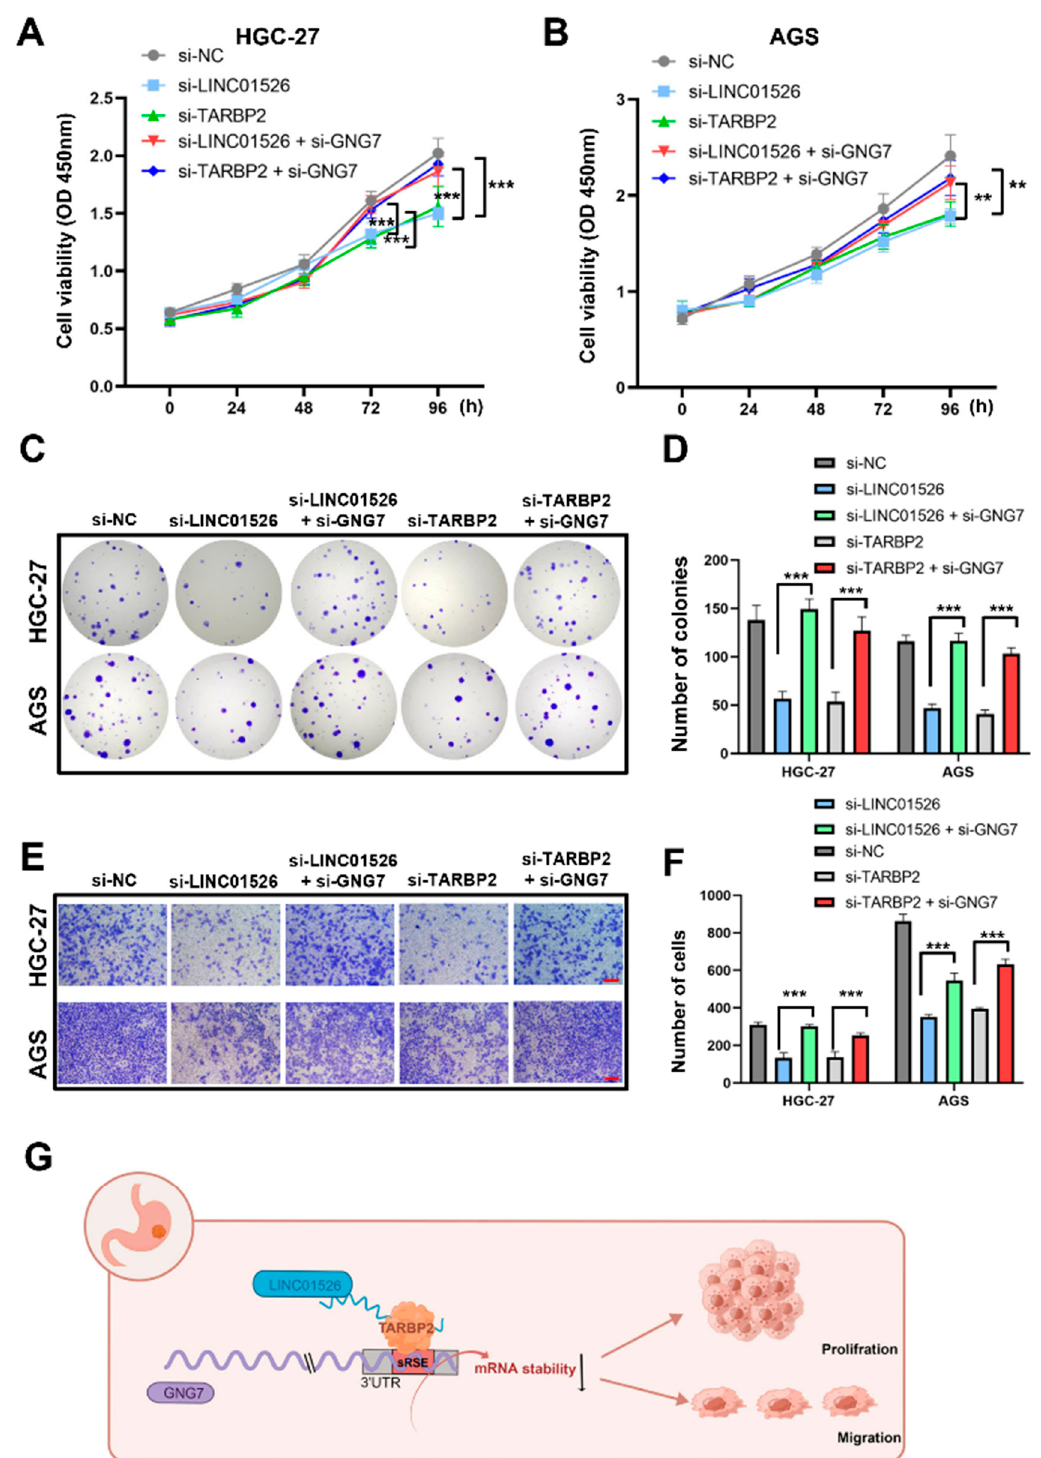
Figure 7. Inhibiting GNG7 reverses the regulatory effect of LINC01526 and TARBP2 in GC cells. ( A , B ) CCK8 assay results showing cell viability in HGC-27 and AGS cells transfected with si- LINC01526 or si-TARBP2, alone or co-transfected with si-GNG7 (n = 6). ( C ) Colony formation assay results showing cell proliferation (n = 3). ( D ) Quantification of results from ( C ). ( E ) Transwell assay results showing cell migration (n = 3), scale bars: 100 μ m. ( F ) Quantification of results from ( E ). ( G ) Schematic diagram of the mechanism by which LINC01526 promotes tumor proliferation and migration in GC cells. ** p < 0.01, and *** p < 0.001.